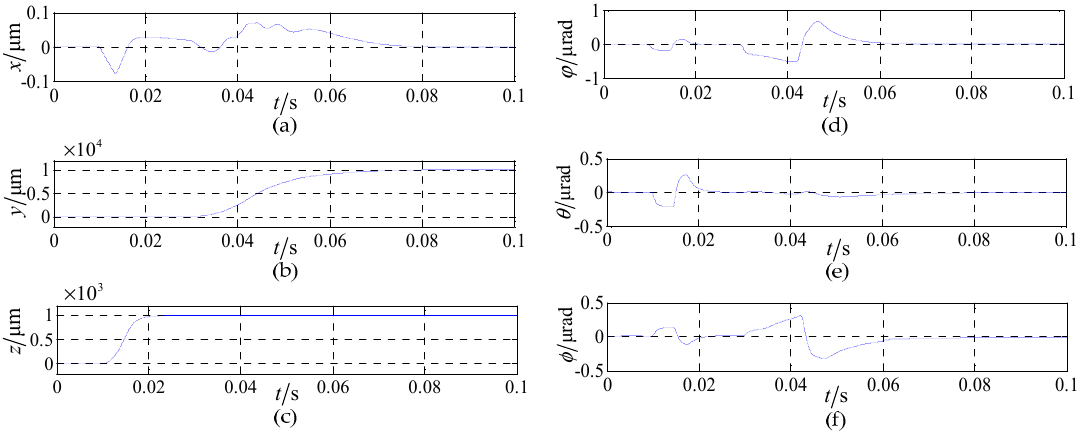
Figure 9. Displacement curve of the control system based on the analytical method.